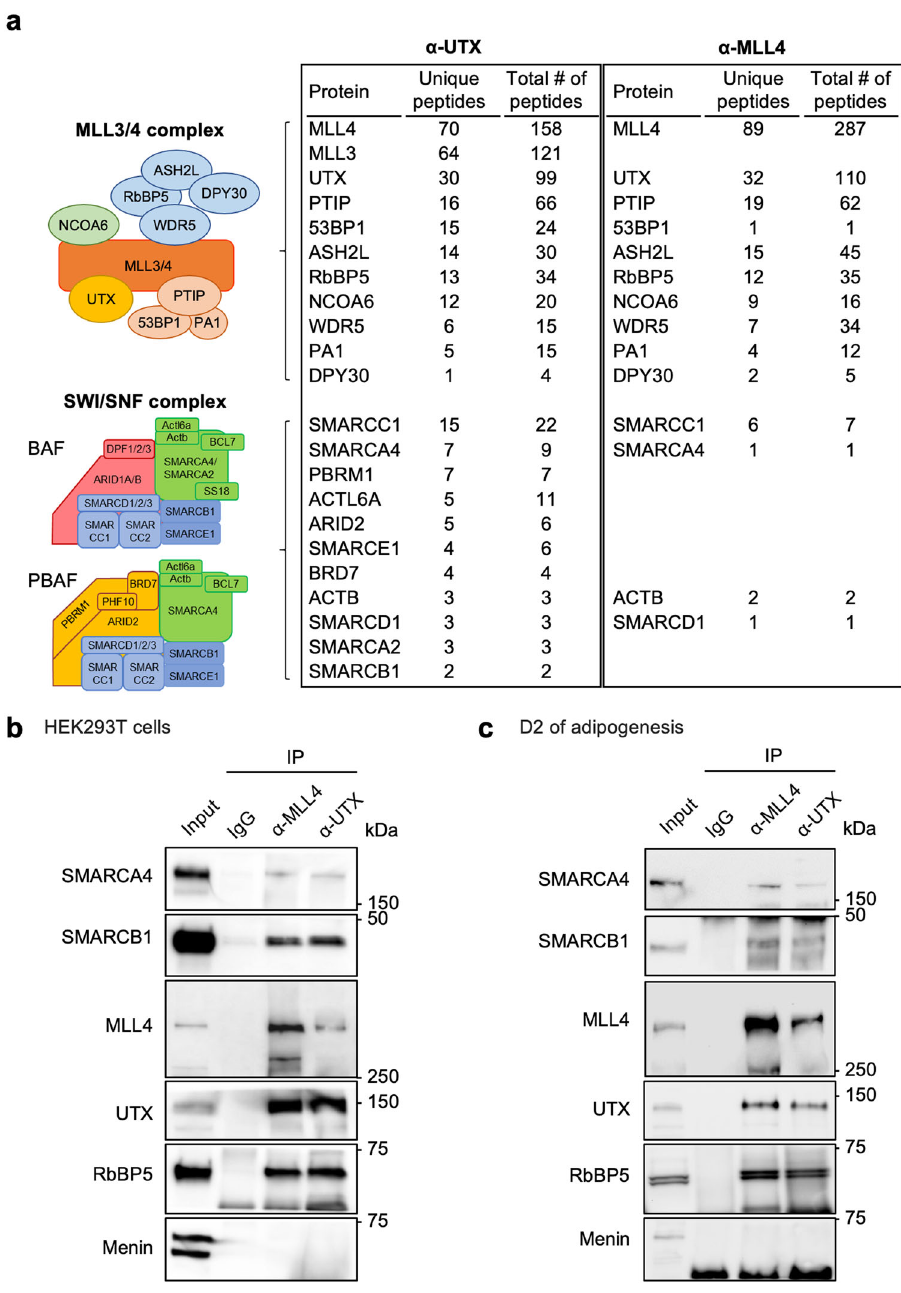
Fig. 4 UTX and MLL4 associate with SWI/SNF complex subunits in cells. a UTX and MLL4 associate with SWI/SNF components in mouse embryonic stem cells. Nuclear extracts were subjected to immunoprecipitation with anti-UTX or anti-MLL4 antibodies. Components of MLL3/4 and SWI/SNF complexes identi fi ed by mass spectrometry after immunoprecipitation of endogenous UTX or MLL4 are presented ( n = 1). Unique and total peptide numbers for IP-enriched BAF and PBAF complex subunits as well as MLL4 complex subunits are shown. Full lists of identi fi ed proteins are presented in the Supplementary Data 1 and 2. b , c MLL4 complex associates with SMARCA4 and SMARCB1 in cells. Nuclear extracts from HEK293T cells ( b ) or preadipocytes during (D2) adipogenesis ( c ) were subjected to immunoprecipitation with anti-MLL4 or anti-UTX antibody. Immunoprecipitates were analyzed by Western blotting with antibodies indicated on the left. n = 2 biological